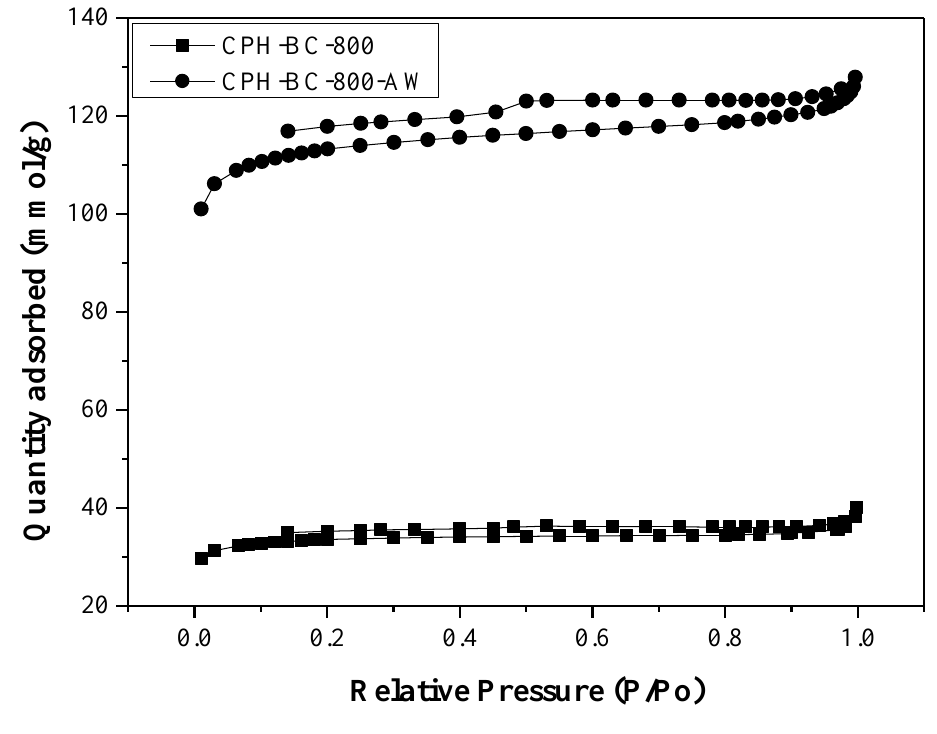
Figure 1. N 2 adsorption–desorption isotherms of CPH-BC-800 products.